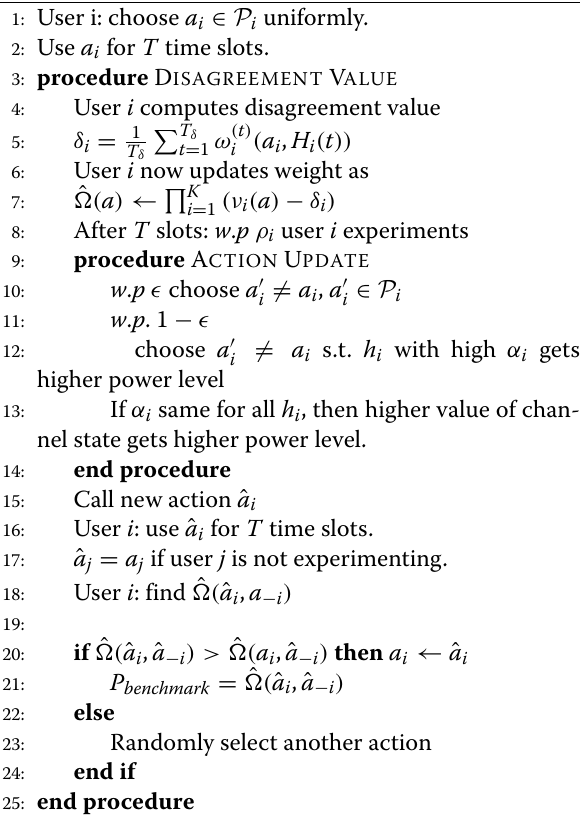
Algorithm 3 Distributed Algorithm to obtain Nash Bar- gaining